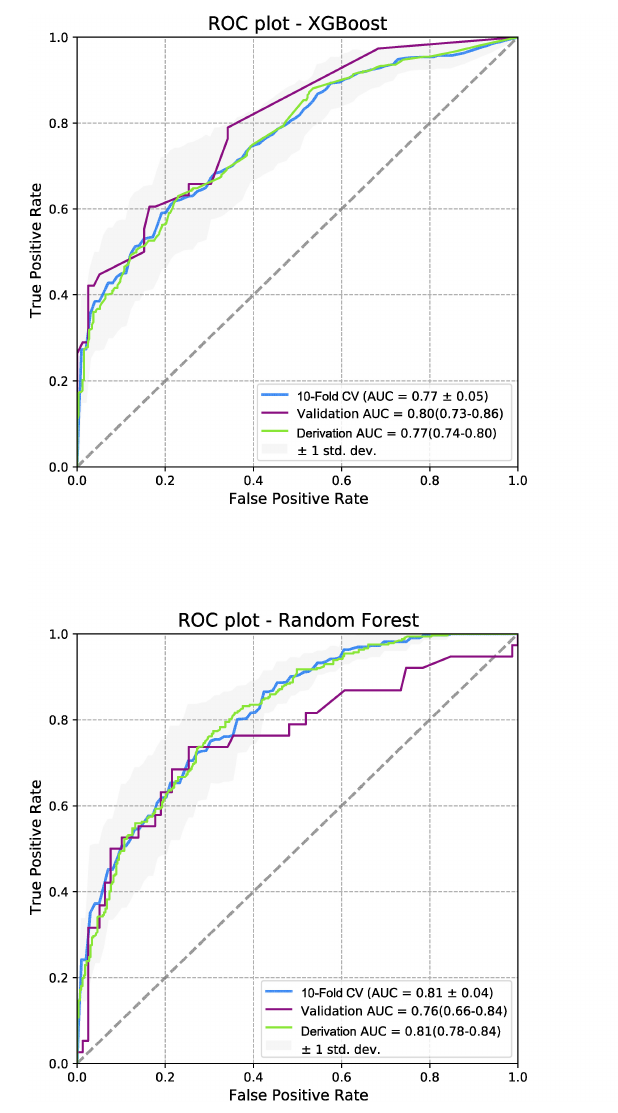
FIGURE3 Receiver operating characteristic curves for post-thrombotic syndrome at 2-year follow-up. ROC, receiver operating characteristic curve; PTS, post-thrombotic syndrome; AUC, area under the curve; XGboost, eXtreme gradient boosting.